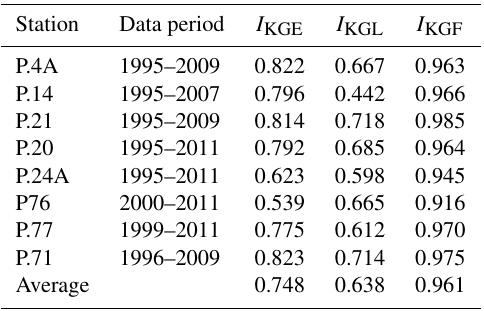
Table 7. FLEX model performance at eight runoff